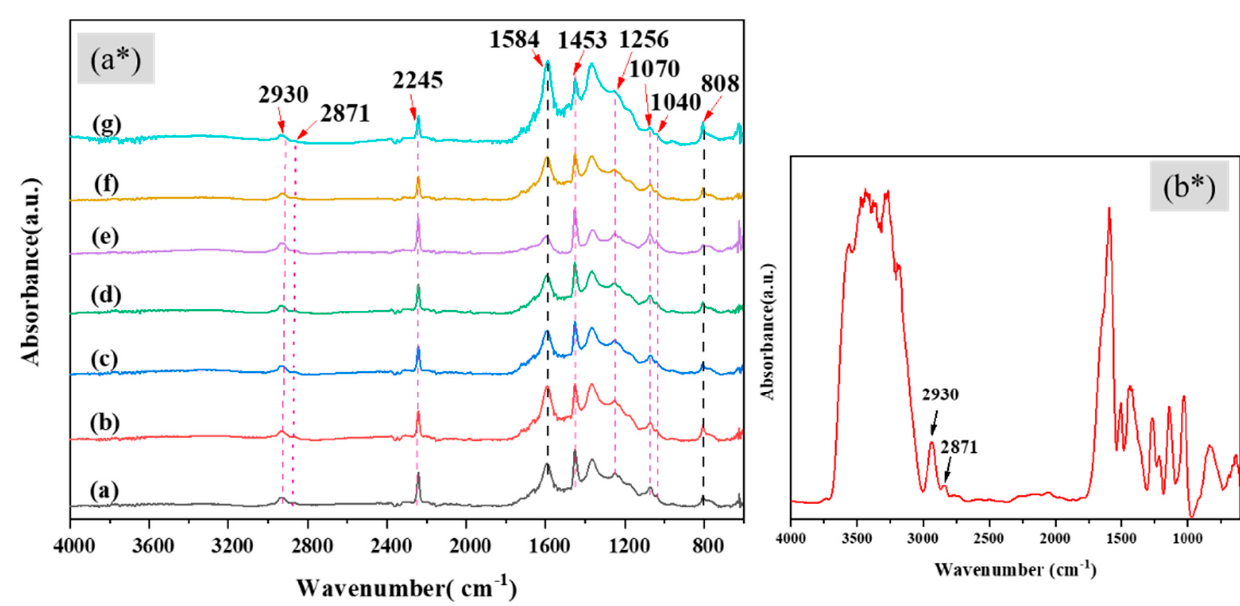
Figure 3. Fourier transform infrared (FTIR) spectra of (a) PAN nanofiber, (b) PAN/AgNPs1, (c) PAN/AgNPs2, (d) PAN/AgNPs3, (e) PAN/AgNPs4, (f) PAN/AgNPs5, and (g) PAN/AgNPs6 ( a* ); FTIR spectra of alkali lignin only ( b* ).